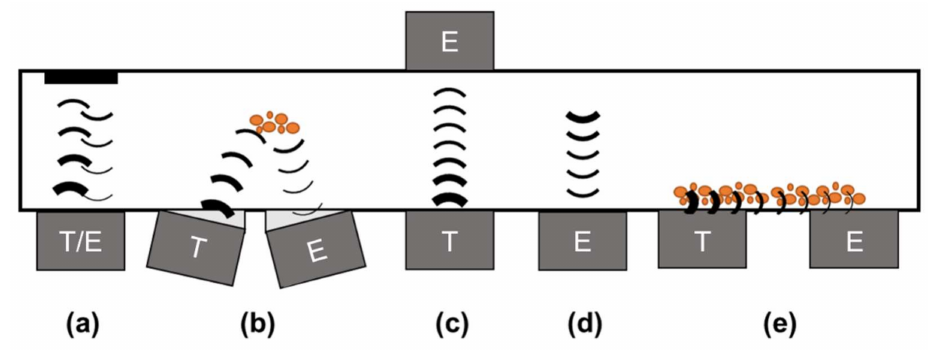
Figure 1. Ultrasound-based measuring setups with transmitter (T) and emitter (E): ( a ) reflection measurement in pulse-echo mode, ( b ) reflection measurement in pitch-catch mode, ( c ) transmission mode, ( d ) emission mode, ( e ) surface acoustic wave measurement in pitch-catch